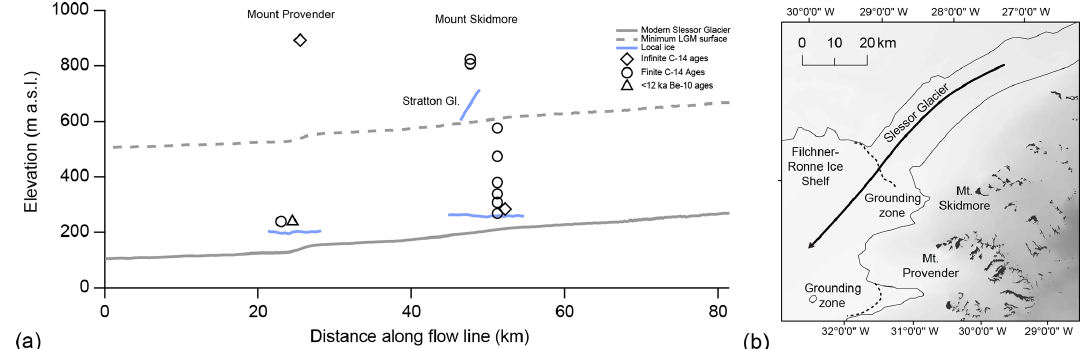
Figure 10. (a) Exposure-age results projected onto an elevation profile along flow line of the Slessor Glacier. (b) Flow line location is shown in the map. Infinite 14 C measurements are offset in regard to their distance along flow line to improve readability. The 10 Be data included are those from Hein et al. (2011, 2014) which yield exposure ages below 12 ka (LSDn scaling, http://antarctica.ice-d.org, last access: 2 November 2019). Elevation data for ice surfaces and map shading are sourced from the Reference Elevation Model of Antarctica (REMA; Howat et al., 2018). Grounding line positions sourced from the MEaSUREs program V2 (Rignot et al., 2011, 2014, 2016). Minimum LGM surface is the modern-day surface profile with the elevation increased above present using our minimum LGM thickness